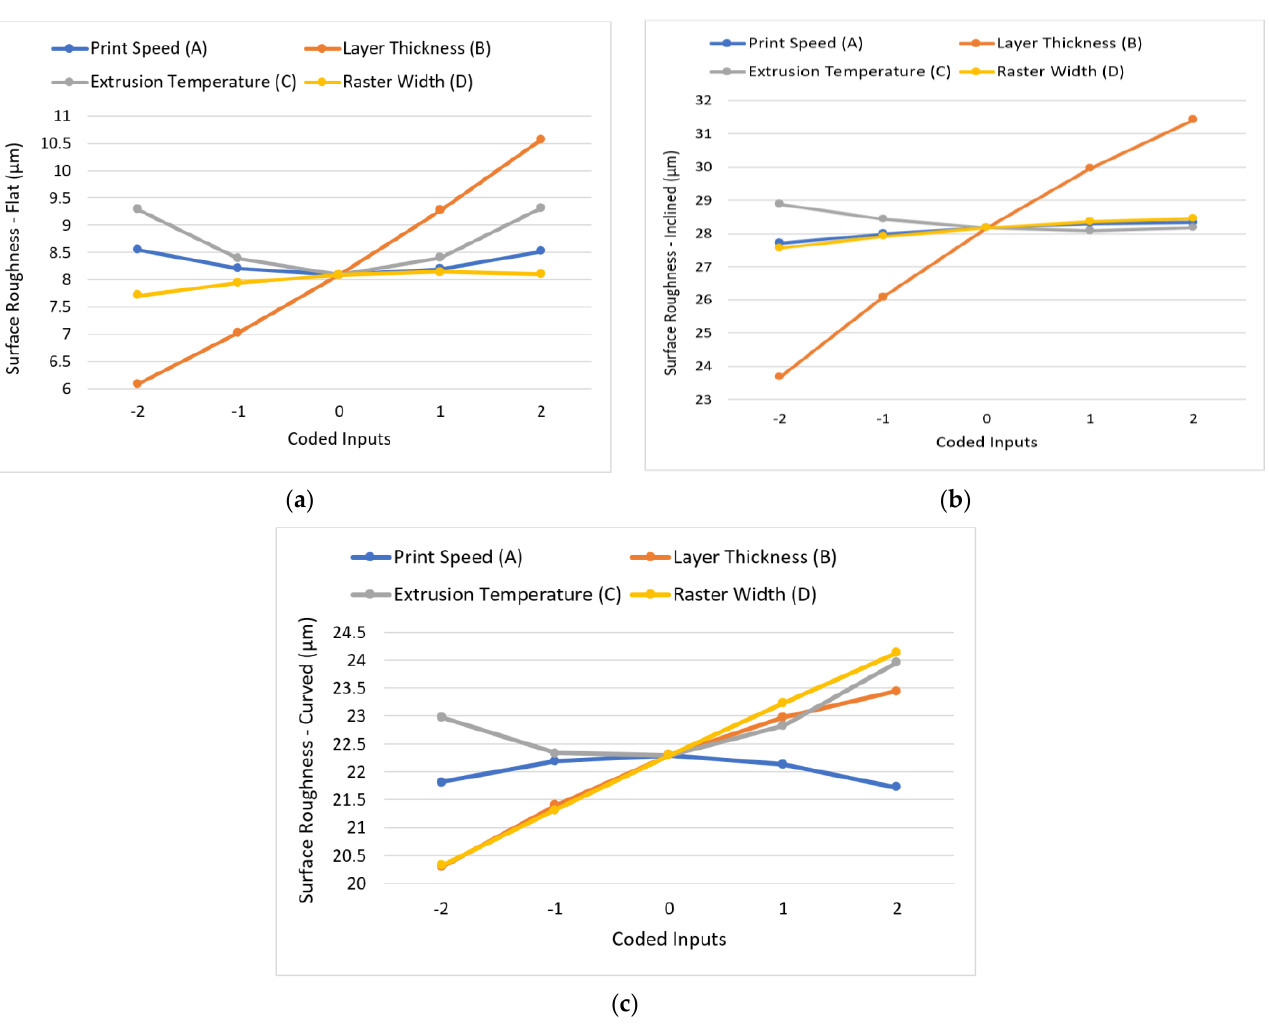
Figure 11. Effect of variation of input parameters on surface roughness: ( a ) flat; ( b ) inclined; ( c ) curved.